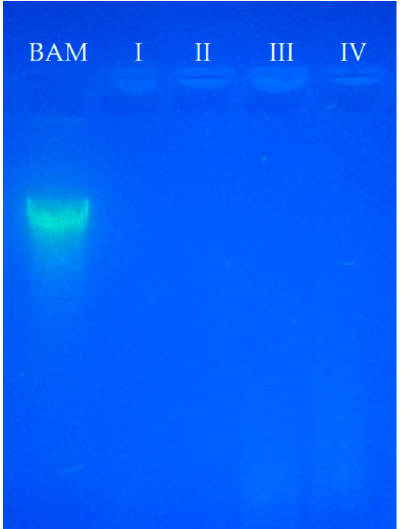
Figure 1. Electrophoresis pattern obtained in agarose gel for the used protocols (I, II, III, and IV), and for the control sample (BAM).